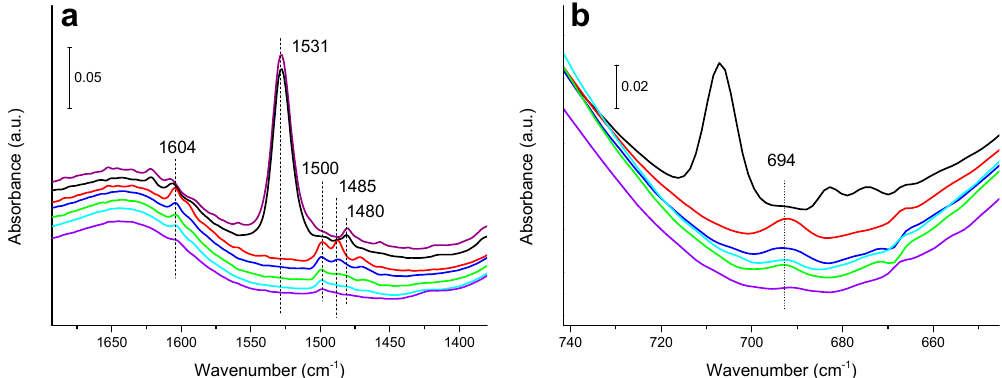
Figure 4. IR study of nitrobenzene and H 2 on: ( a ) Cu 2 Pd/SiO 2 sample, and their evolution with the reaction temperature 25 ◦ C (black), 60 ◦ C (red), 90 ◦ C (blue), 120 ◦ C (green), 140 ◦ C (cyan) and 180 ◦ C (violet). Purple colored line corresponds to the sample after nitrobenzene and before H 2 co-adsorption at 25 ◦ C. ( b ) corresponding IR spectra in the low frequency range.